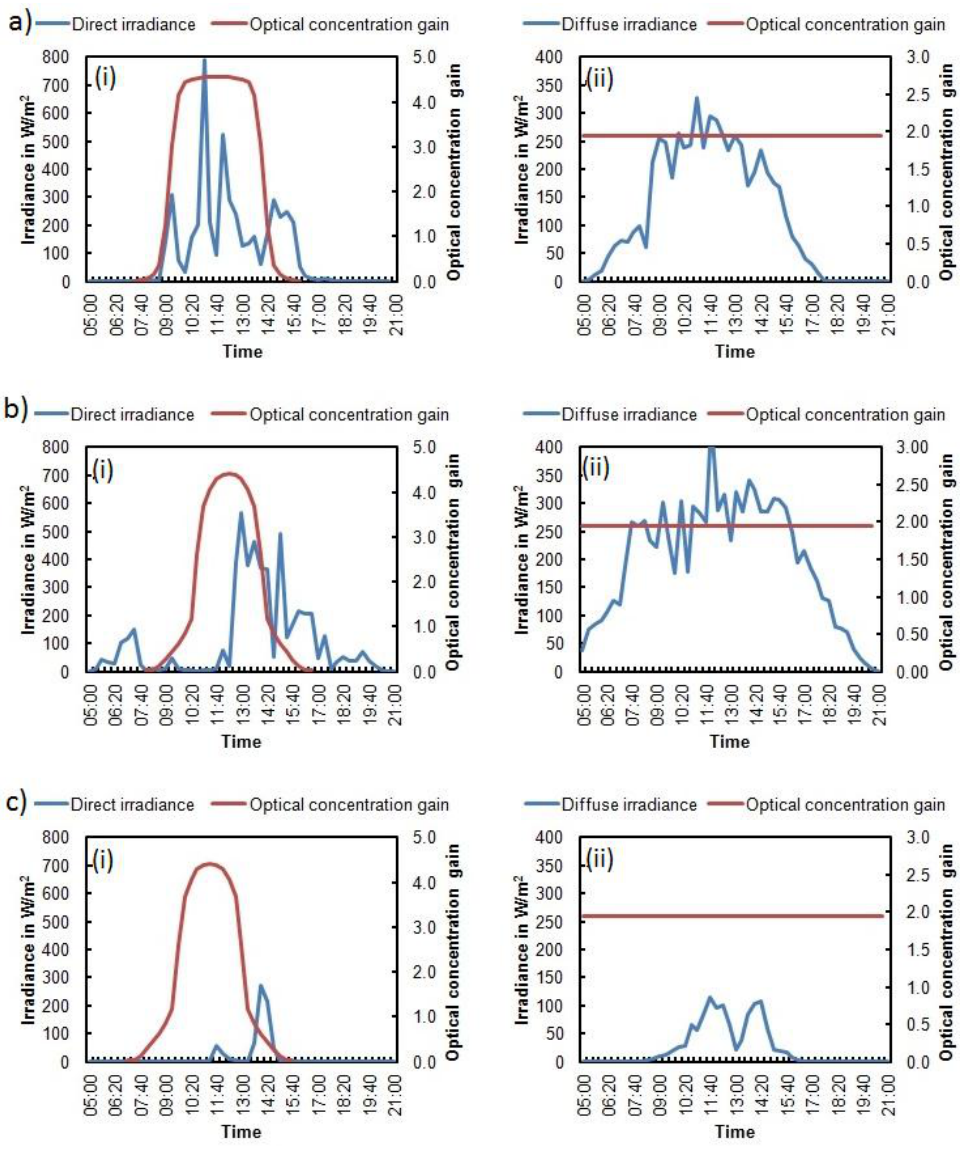
Figure 9. Predicted performance of the RADTIRC-PV module in: ( a ) March; ( b ) June; and ( c ) December in Berlin/Brandenburg.